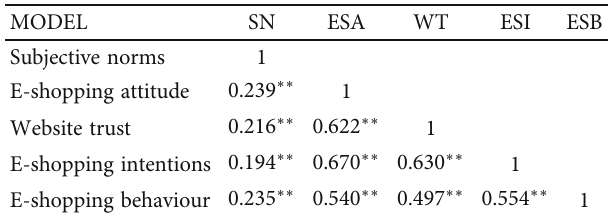
Table 7: Pearson correlations matrix.